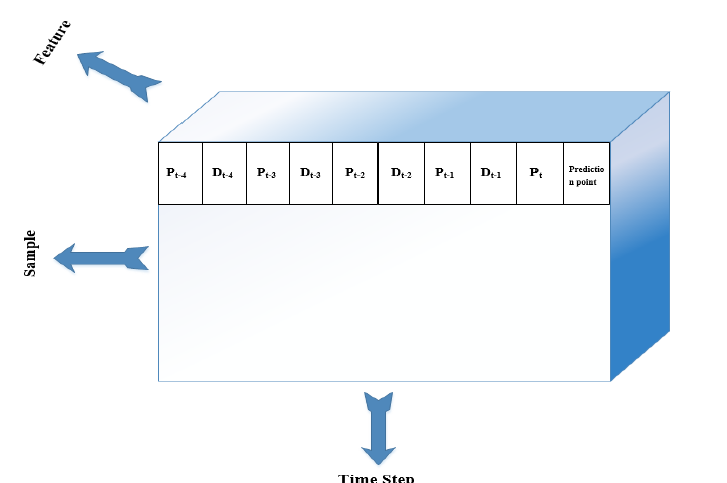
Figure 7. Driver’s trajectory fed into our model ( P t are pick-up points and D t are drop-off